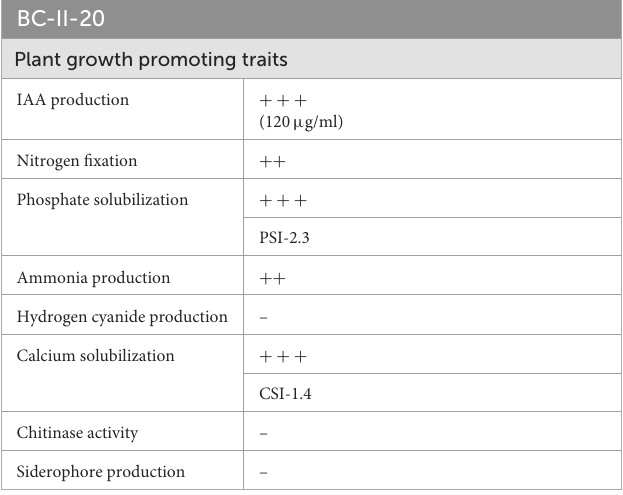
TABLE 2 Qualitative analysis of plant growth-promoting traits of bacterial isolate BC-II-20.